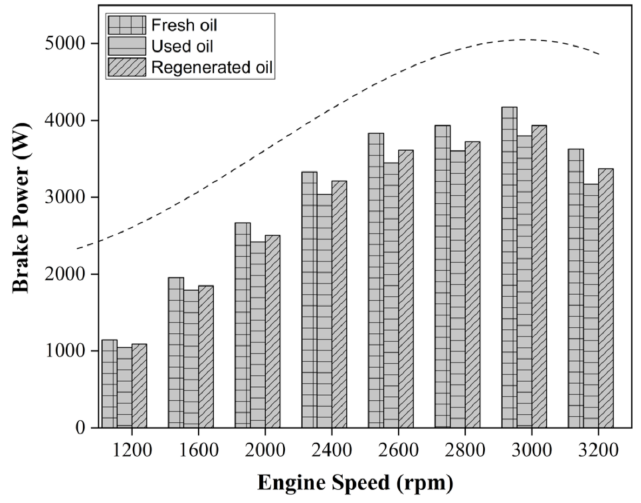
Figure 5. Brake power variation with speed.